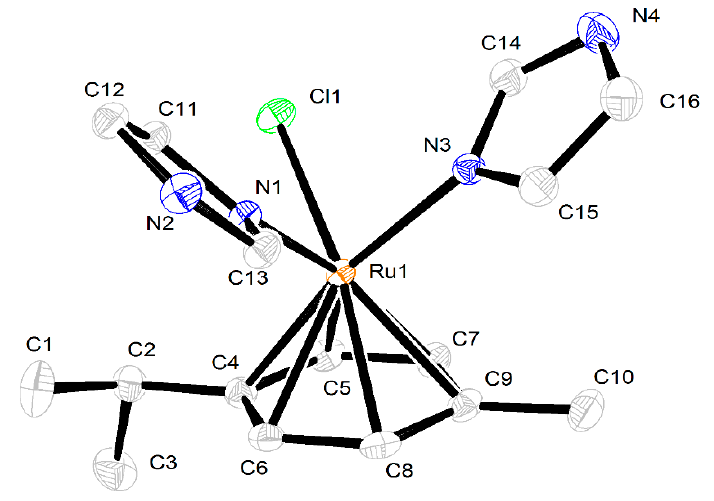
Figure 2. X-ray molecular structure of complex 1 . Thermal ellipsoids are drawn at a 50% probability level. Hydrogen atoms and Cl − anions are omitted for clarity.